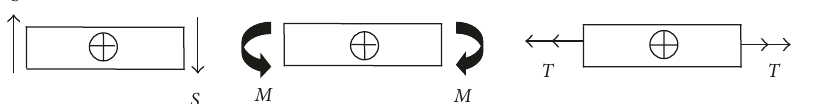
Figure 2: Sign convention, where S denotes the transverse force, M denotes the bending moment, and T denotes the torque.